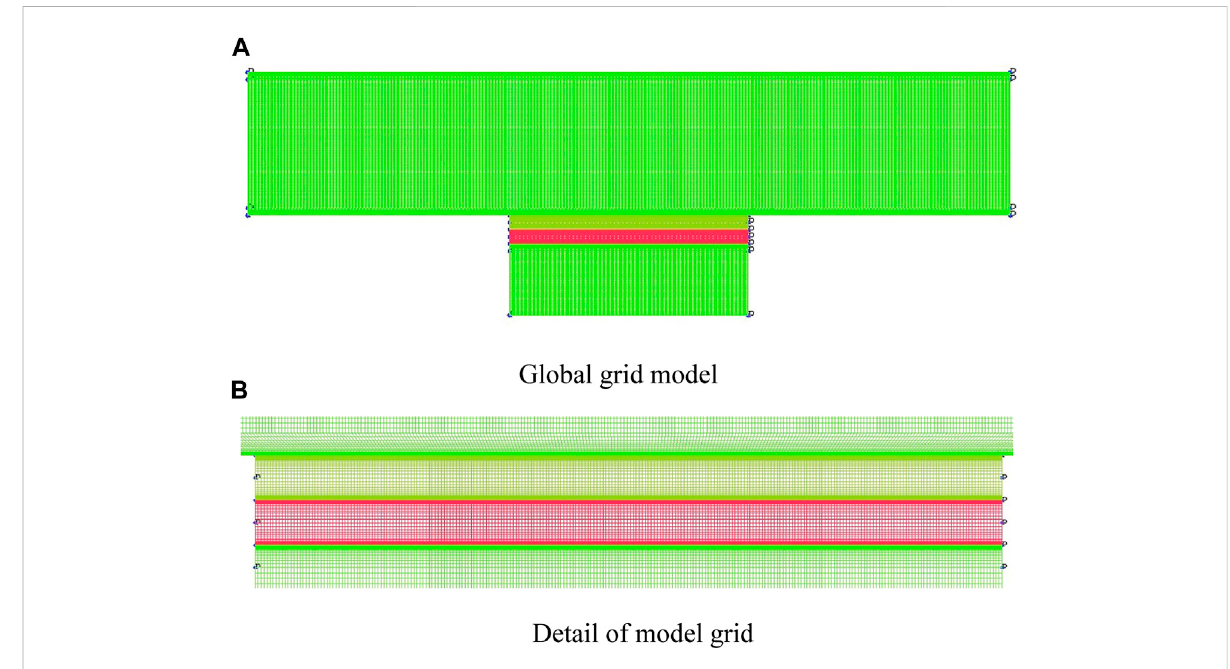
FIGURE 3 Computational domain grid. (A) Global grid model, (B) Detail of model grid.